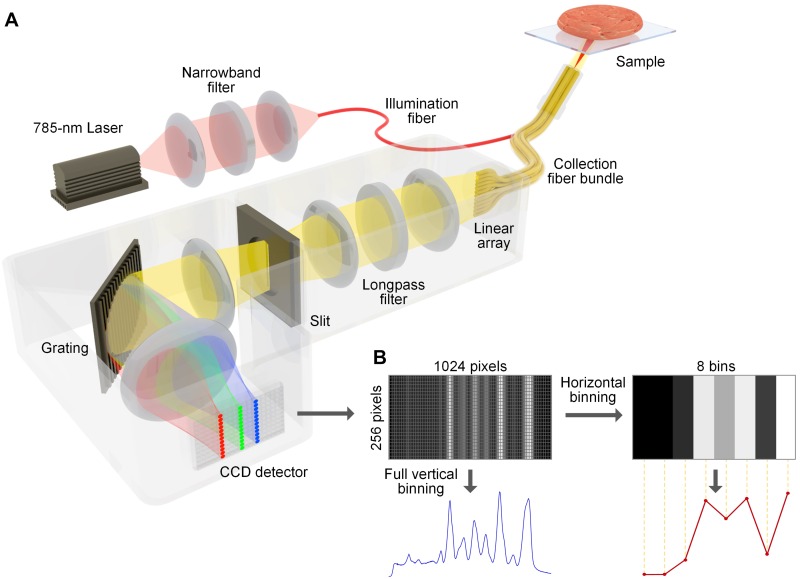
(A) The REMI system and (B) the channel-compression strategy.(A) Schematic of the spectral-imaging system. A 785-nm laser is used to illuminate the NP-stained tissue, creating a 1 mm-diameter laser spot. Raman-scattered photons from illuminated NPs are collected by 27 multimode fibers and transmitted to a customized spectrometer, where they are dispersed onto a cooled deep-depletion spectroscopic CCD. (B) The camera is used in full-vertical binning (FVB) mode, in which the signal from all 27 collection fibers are binned together by the camera, with 1024 pixels (spectral channels) used to resolve the grating-dispersed wavelength axis. In this study, the 1024-channel data set is further binned along the wavelength axis (horizontal binning) to examine the effects of spectral compression.